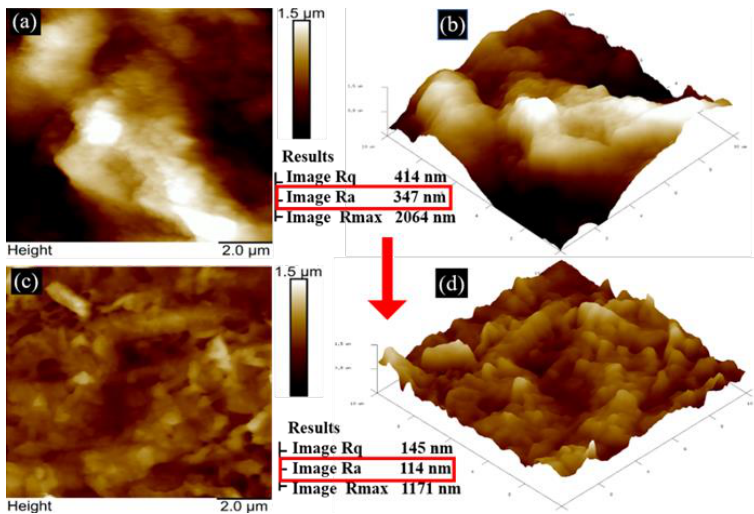
Figure 3. Atomic force microscopy images in 2D and 3D forms of ( a ) and ( b ) pure Mg, and ( c ) and ( d ) Mg-OH-AA-BSA, after polarization test in SBF at 37 °C.